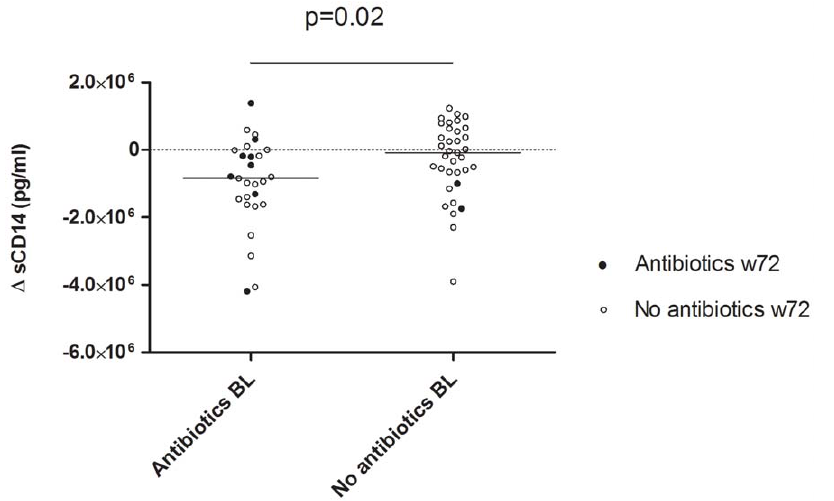
Figure 7. Change ( D ) in sCD14 levels in relation to antibiotics. Change ( D ) in sCD14 levels between baseline (BL) and 72 weeks of treatment (w72). Patients treated with antibiotics at BL had a larger reduction in sCD14 levels at w72 than those who did not receive antibiotics at BL. P-value refers to Mann-Whitney test.